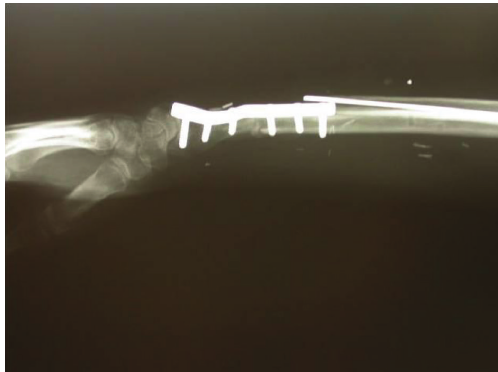
Figure 5: Postoperative at 2 weeks.